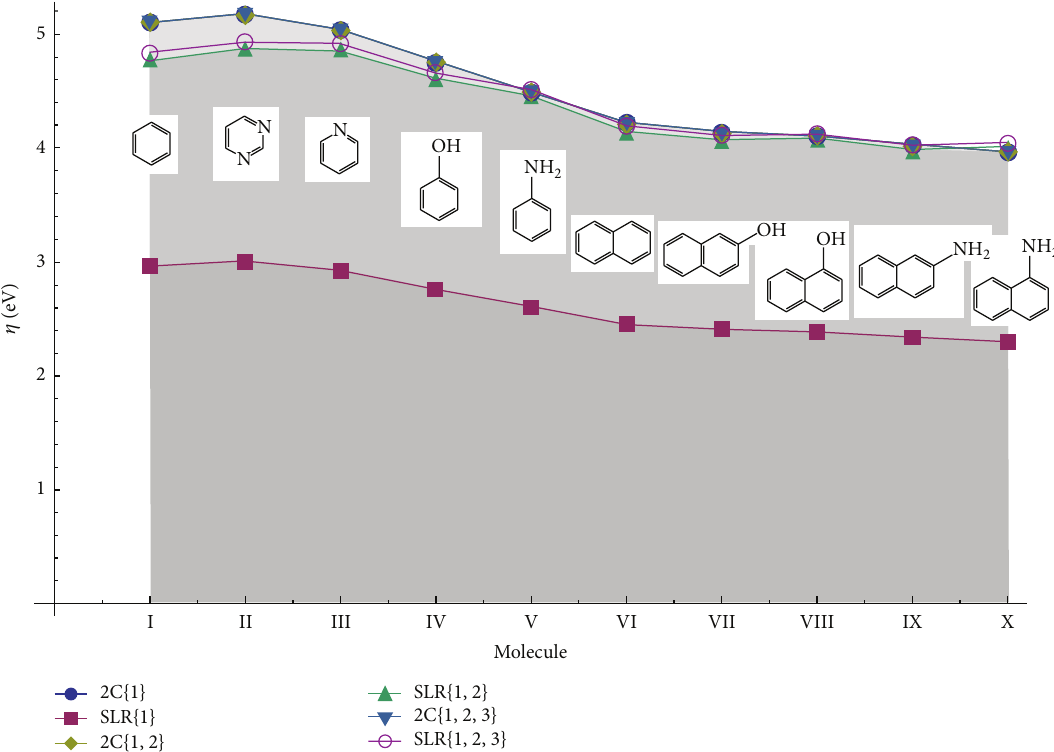
Figure 2: Representation of the 2C and SLR chemical hardness hierarchies for the set of molecules of Table 1 upon the first, second, and third orders of Koopmans’ theorem applications as presented din Tables 3, 4, and 5,